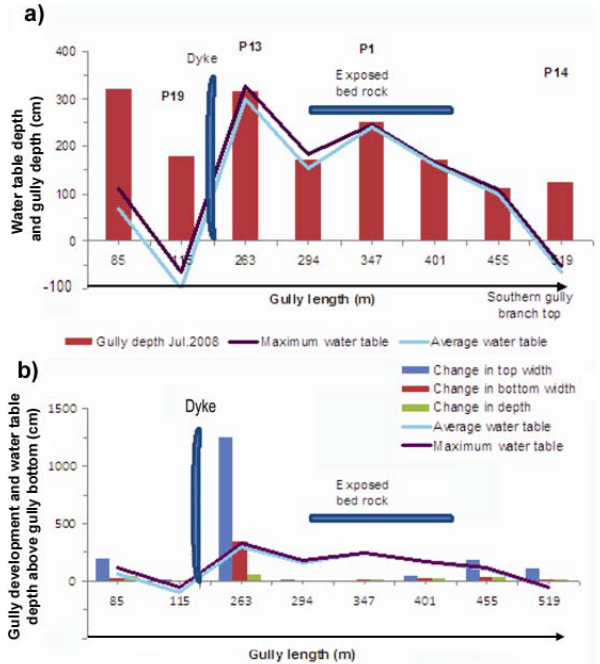
Fig. 8. (a) Gully dimensions before and after the 2008 rainy sea- son for the southern gully, branch B (note the gully bottom is the reference elevation) and (b) average ground water table depths and change in top and bottom width and depth of the